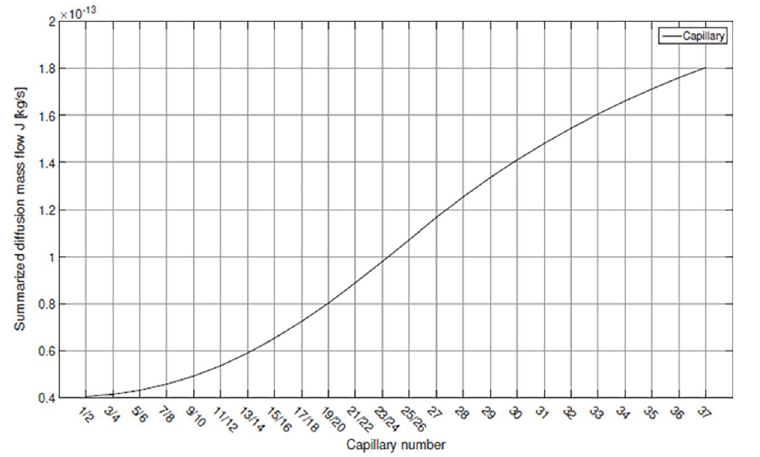
Fig 15. Integrated diffusion mass flow J for each